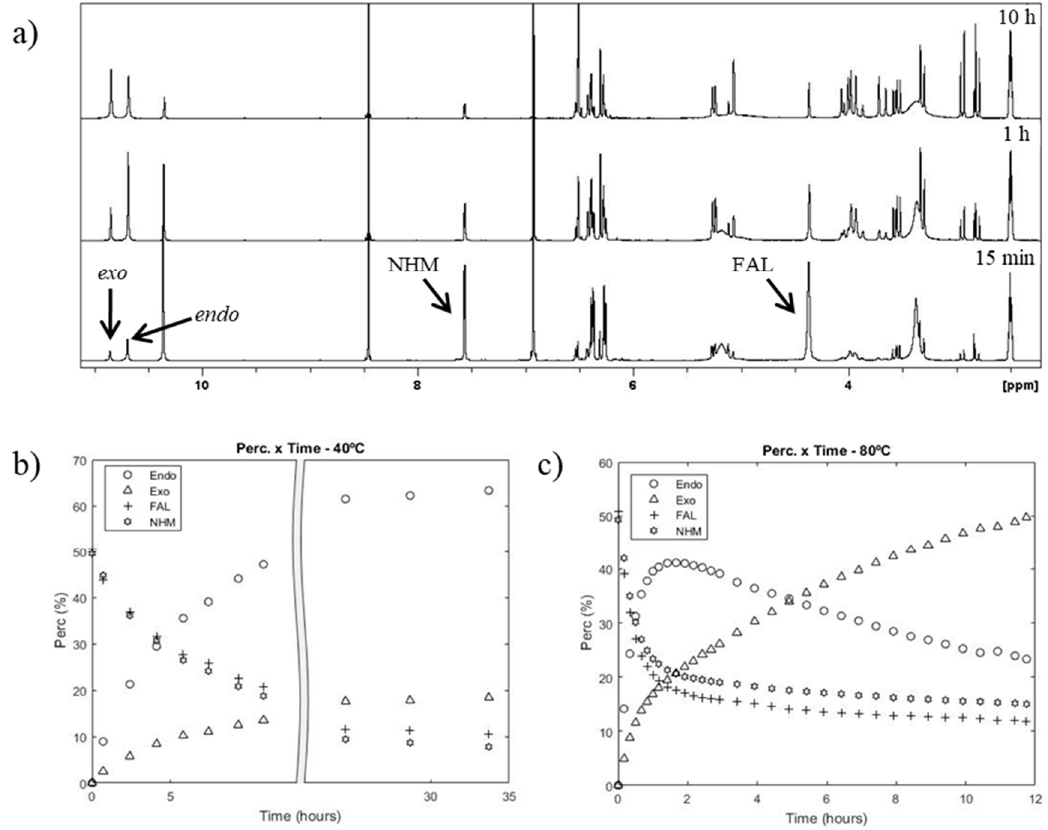
Figure 2. ( a ) Proton NMR spectra of the furfuryl alcohol / N -Hydroxymaleimide (FAL–NHM) reaction at different times and at 60 °C; ( b ) Percentage (%) versus time (hours) of FAL–NHM reaction at 40 °C; ( c ) Conversion (%) versus time (hours) of FAL–NHM reaction at 80 °C.